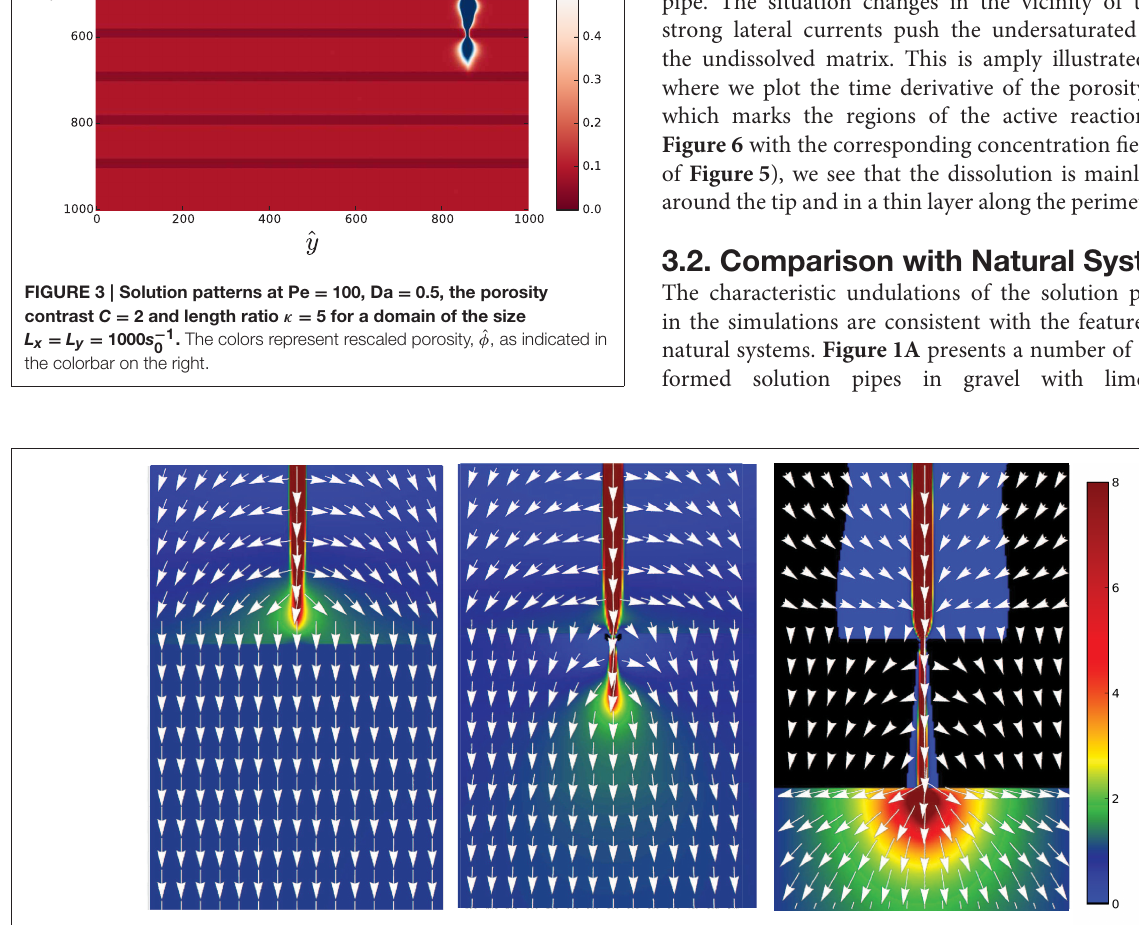
FIGURE 4 | The Darcy flow field around the tip of the pipe before hitting one of the layers (left), with the tip located within the layer (center), and after emerging from the layer (right). The colors represent the magnitude of the flow scaled by v 0 . The lengths of the vectors in the overlaying vector plot has been scaled to v ( x , y ) 1 / 5 to aid